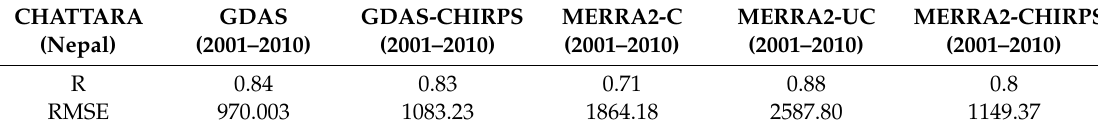
Table 4. The Pearson correlation coefficient and the root mean square error between the daily model and the observed streamflow at Chattara (Nepal) (see Table 1 for details about simulation).